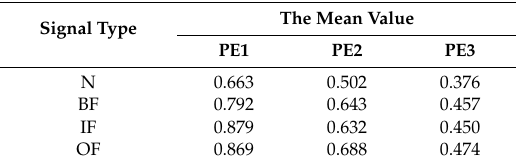
Table 1. Permutation entropy (PE) mean value of the first three IMF components. N: normal signals, BF: ball fault, IF: inner ring fault, OF: outer ring fault.